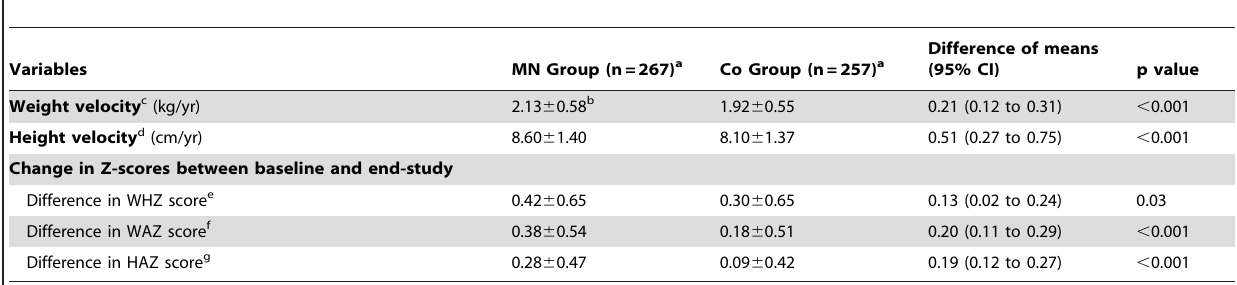
Table 3. Effect of fortification on anthropometric parameters among fortified milk vs. control milk group children after 1 year of intervention.